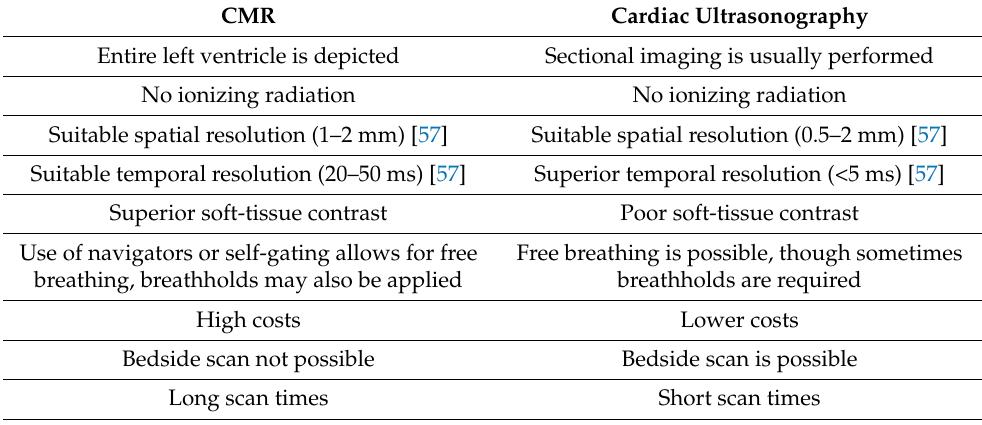
Table 1. Benefits and limitations of CMR as opposed to cardiac